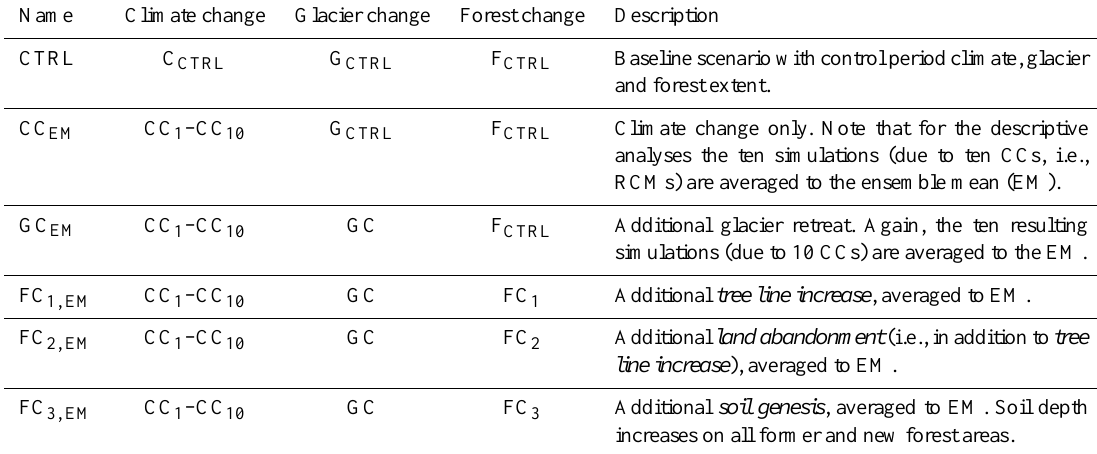
Table 2. Nomenclature of scenario combinations for the descriptive analysis (cf. also Fig. 4, upper half). CTRL always corresponds to the control period from 1984–2005, each scenario is valid for the scenario period from 2074–2095. Note the successive structure of the scenario combinations: per scenario just one member in the chain is